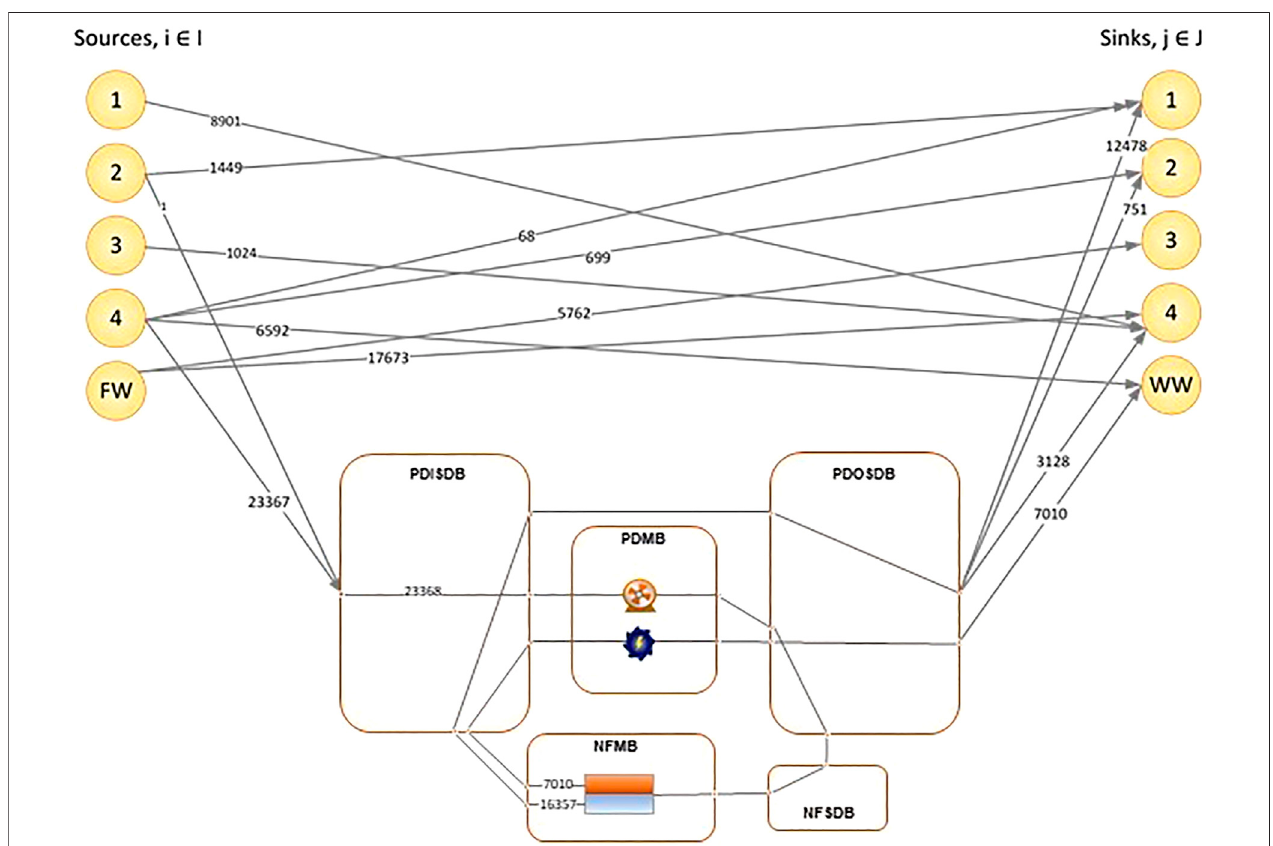
FIGURE 5 | Optimal network for scenario D (detailed regenerator model with customized